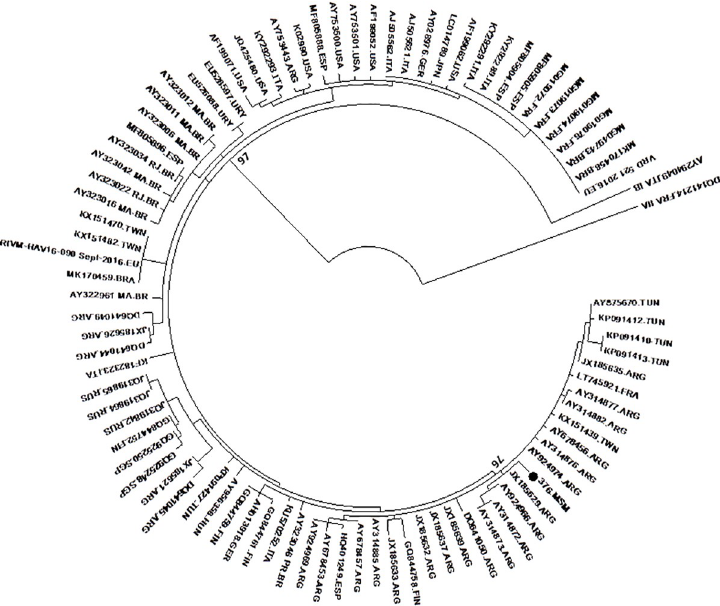
Fig 1. Maximum likelihood phylogenetic tree based on 85 HAV VP1-2A genotype IA sequences. In addition, sequences of genotypes IB and IIA were included as an outgroup. HAV sequence from this study.